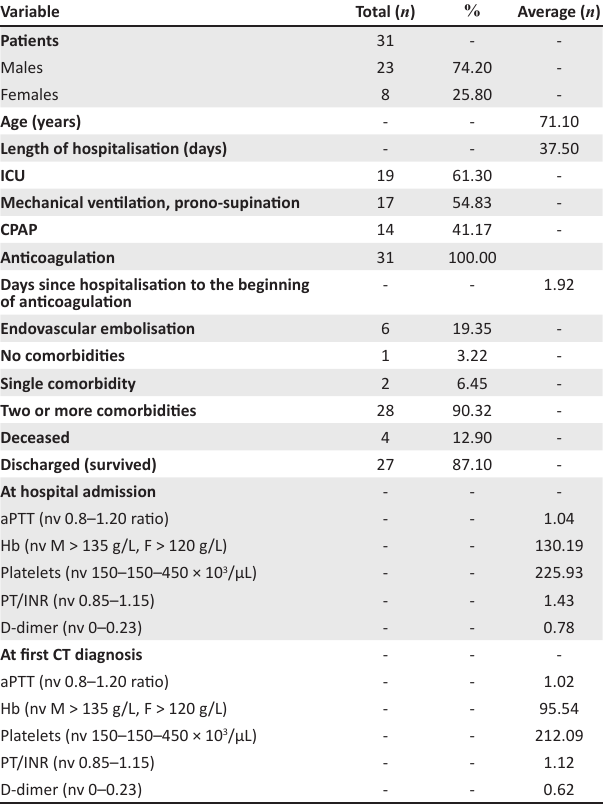
TABLE 2: Patient characteristics, clinical features, treatment, outcome and laboratory tests.